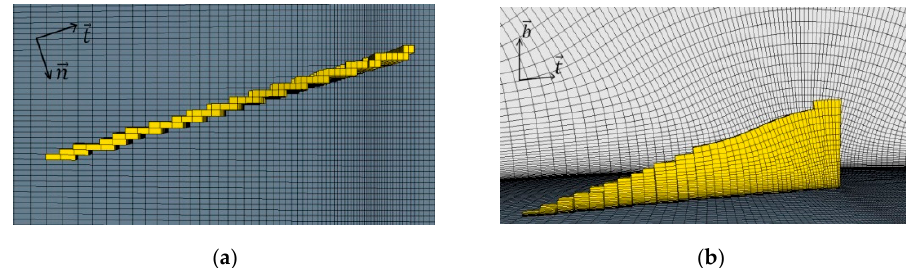
Figure 4. Cells corresponding to the VG device where body forces are applied: ( a ) top view and ( b ) side